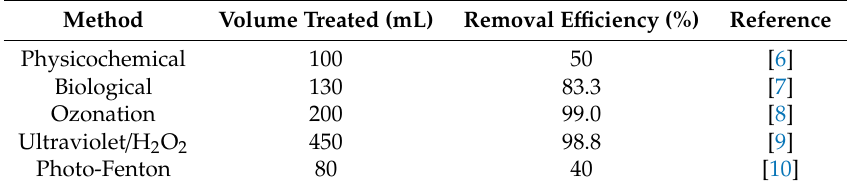
Table 1. Comparison of degradation performance of IBU of di ff erent